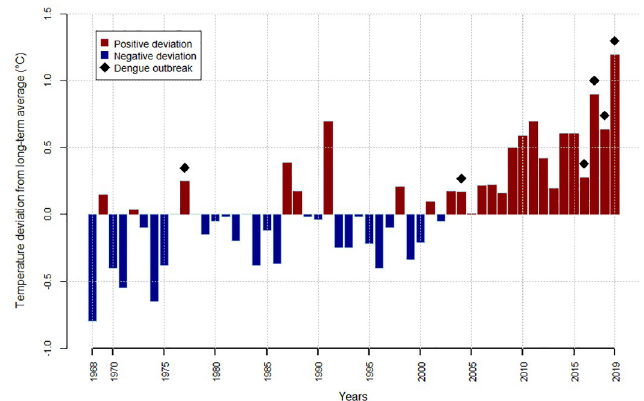
Fig 4. Average annual temperature in Reunion Island, 1968 to 2019 (deviation from long-term average). Black diamonds indicate dengue outbreaks.